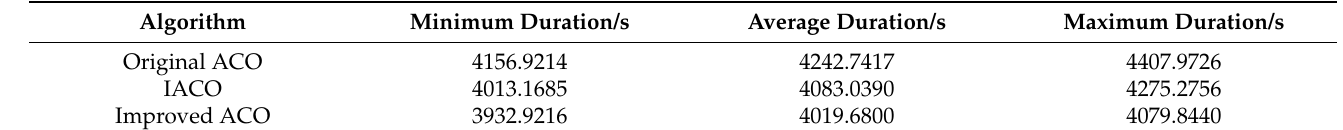
Table 4. Statistical results of T obtained by running the simulation 50